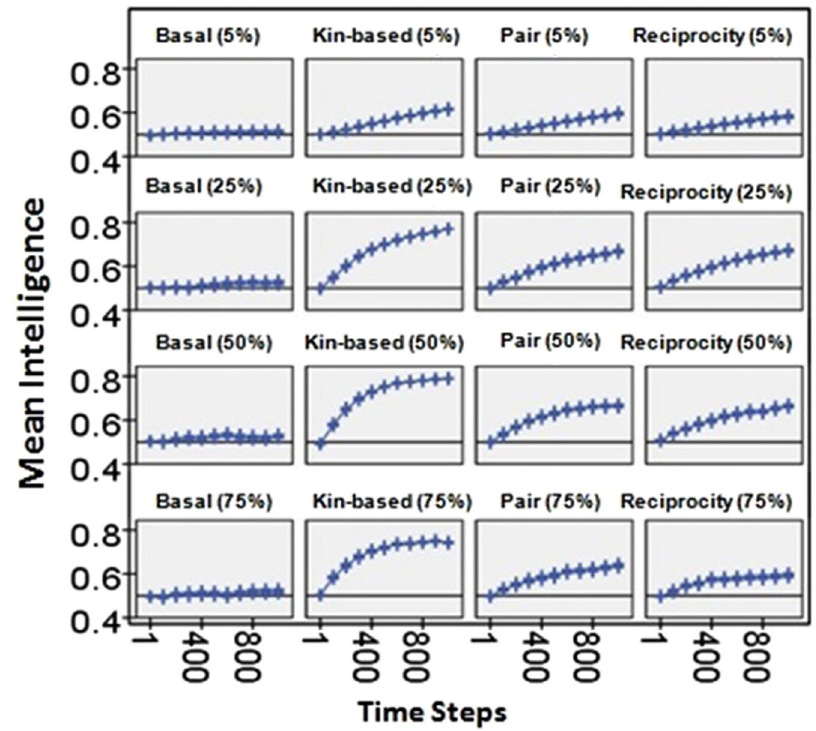
Figure 5. Change in intelligence overtime as produced by disease with a severity of 0.1 under four social systems (columns) and the four initial prevalences (rows, in parentheses). Across social systems the basal social system produced less change than the others. Increasing the initial prevalence from 5% to 50% increases the slope of the change in intelligence. This occurs because the disease affects more individuals, more of the population is engaged in care-giving, and selection occurs more rapidly. Error bars are 95% confidence intervals. The graph pools across community